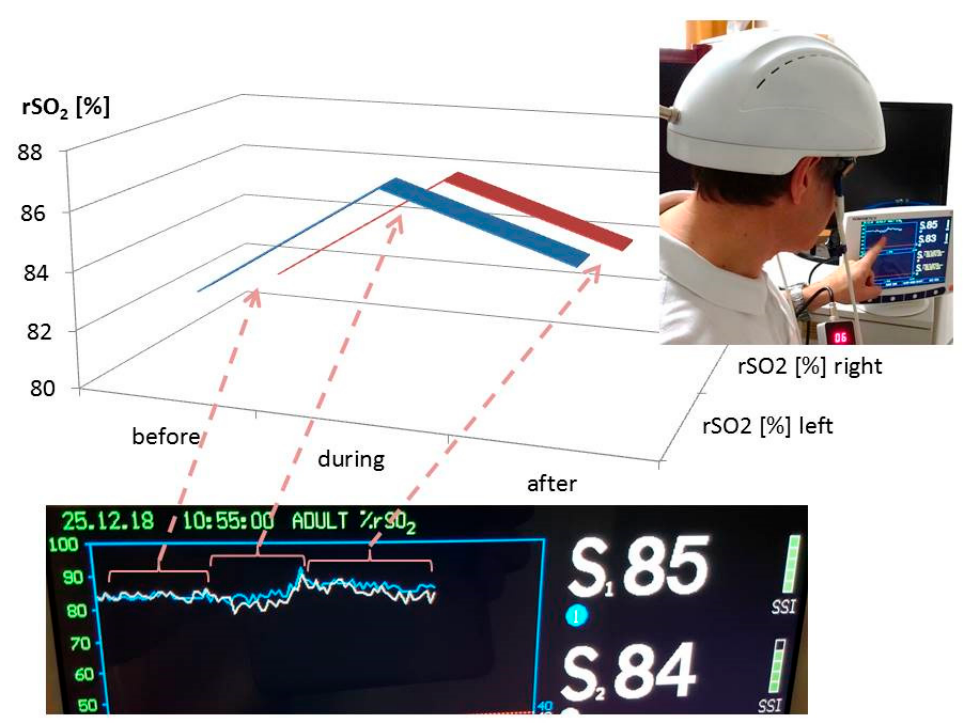
Figure 3. Results of the first pilot measurement with the LED stimulation helmet from Suyzeko (Shenzhen, China). Note the increase in the regional cerebral oxygen saturation during and after stimulation on the left and right side.